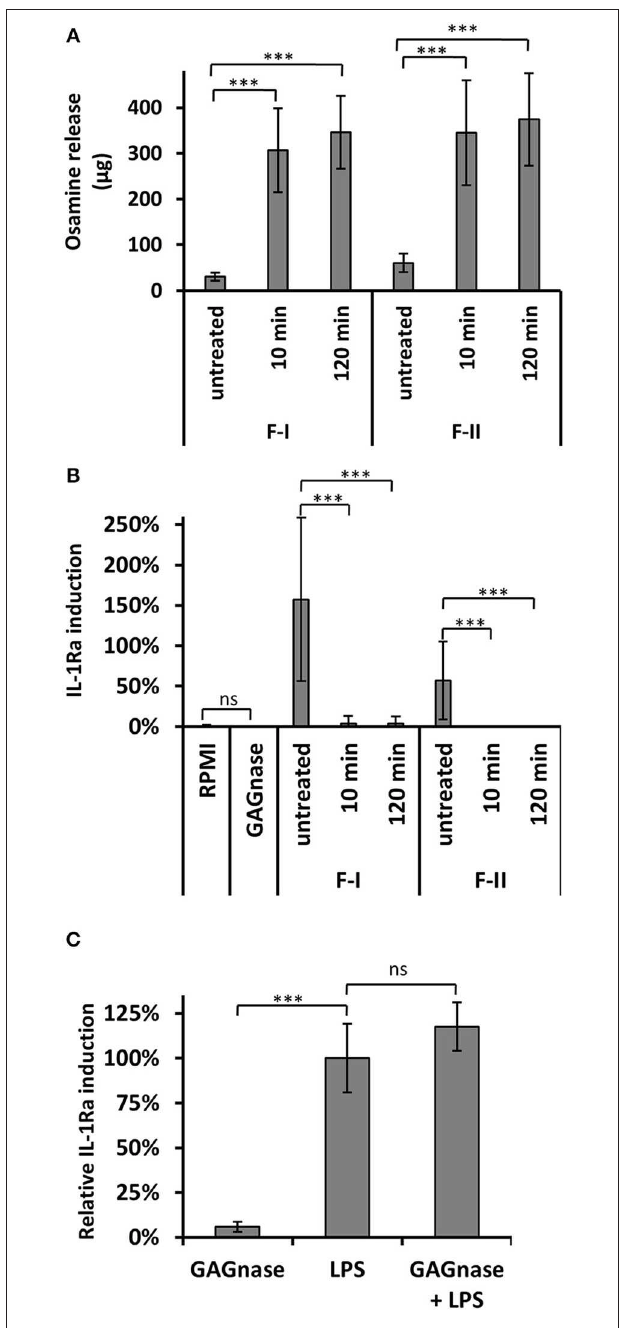
FIGURE 3 | IL-1Ra stimulation by GAG oligomers is abolished by GAGnase. (A) Fraction F-I and F-II are degraded by GAGnase. Fractions I and II (500 µ g/ml) were enzymatically hydrolyzed by GAGnase (2 µ g/ml) for 10 or 120min or were kept in acetate buffer for 120min (untreated). The degradation was followed by PABA assay to quantify sugar reducing end. (B) Induction of IL1-Ra expression in PBMCs by GAGnase treated fractions. (C) IL-1Ra induction of PBMCs in presence of GAGnase (20 ng/ µ l). GAGnase neither activate nor inhibit induction. LPS (10ng/ml) served as reference control and were set to 100% in each biological replicate. bars indicate the SD, WMW Test: *** p < 0.001; ns, not significant (compared to control